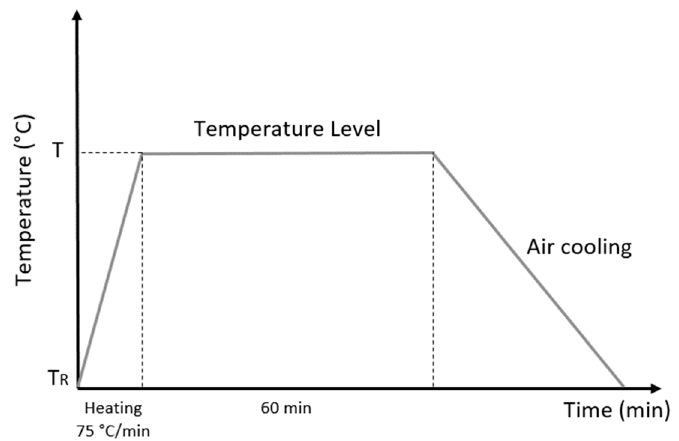
Figure 1. Schematic representation of heat treatment, where T is the temperature in the range of 200–850 °C and TR is room temperature.